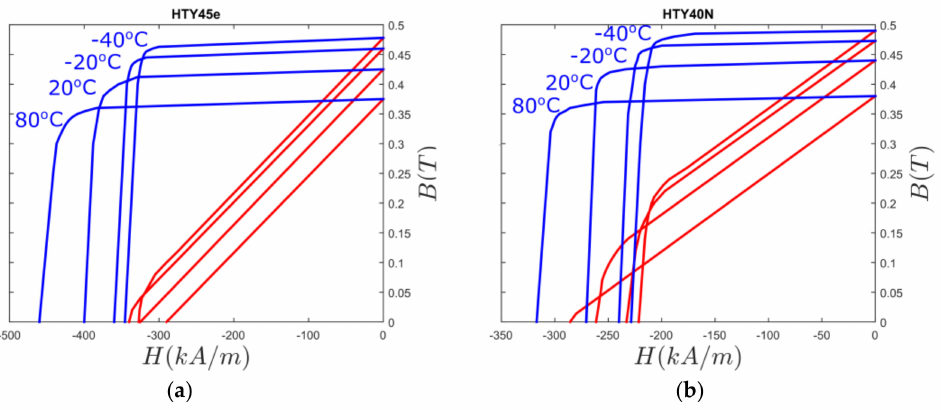
Figure 4. Demagnetization curves for ferrite magnet grades for the ferrite magnet manufacturer Spacemagnets. ( a ) HTY45E; ( b )